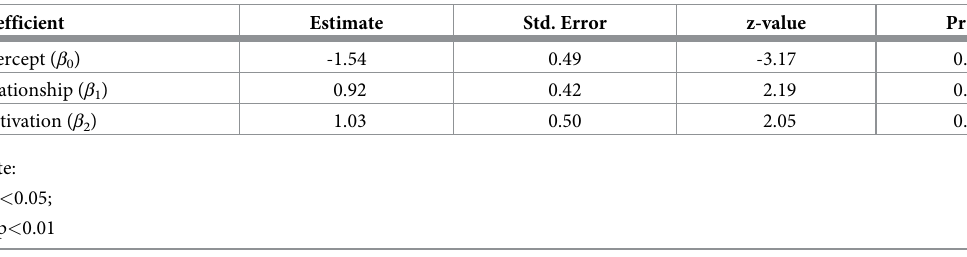
Table 7. Summary of coefficient estimates for the main effects GLM. This model was determined using change in deviance (see Table